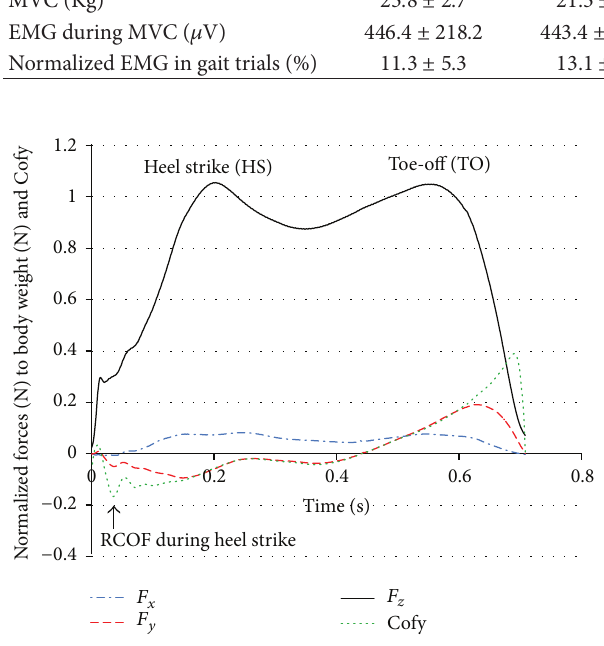
Figure 5: Example of GRFs and RCOF used for analysis, the vertical force ( 𝐹 𝑧 ), longitudinal shear force ( 𝐹 𝑦 ), and transverse force ( 𝐹 𝑥 ) during the HS and TO phases. The second peak of Cofy indicated by an arrow at the bottom represents the RCOF during heel strike.